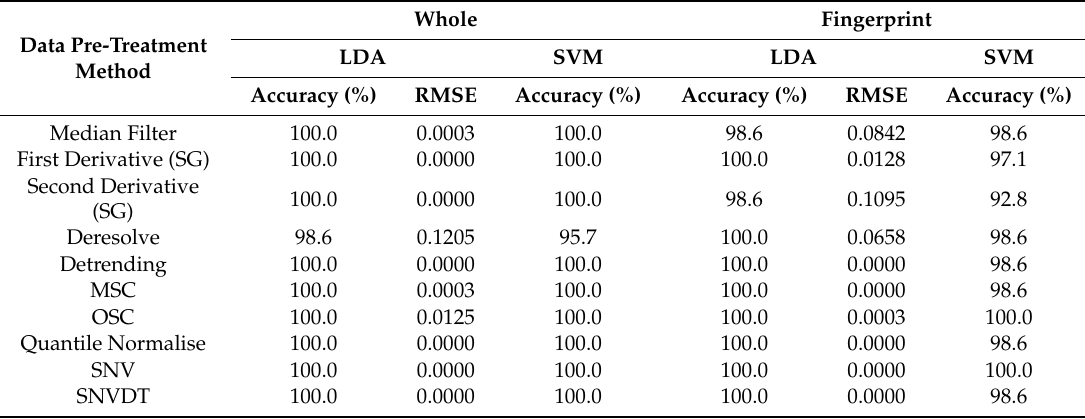
Table 3. Summary of SVM and LDA Model performance with no variable selection on the ‘whole’ spectrum and on fingerprint region